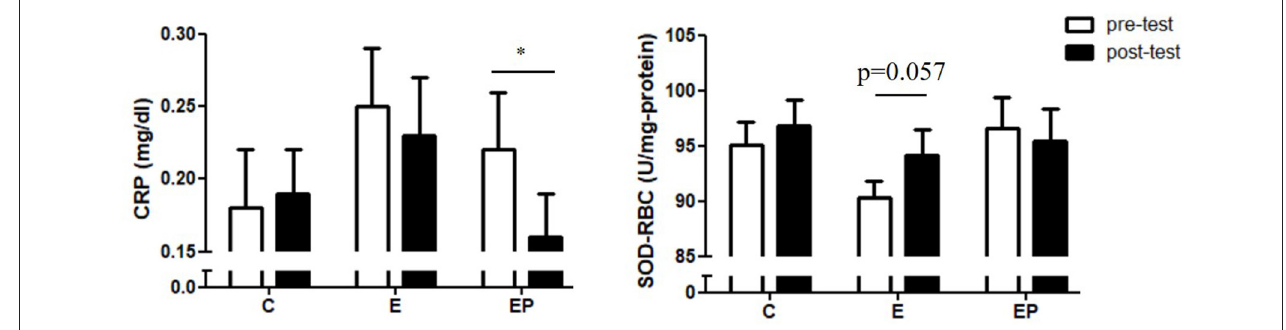
FIGURE 6 | Effects of intervention on inflammatory and oxidative stress markers. Data were presented as mean ± SE. C, control group; CRP, C-reactive protein; E, exercise group; EP, exercise combined with high-protein diet group; SOD-RBC, superoxide dismutase activity in red blood cells. * p < 0.05.